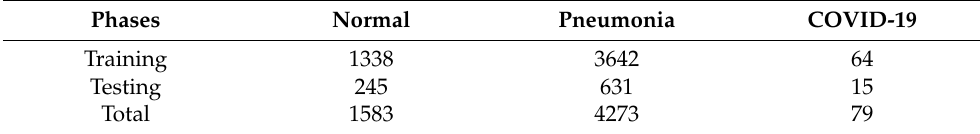
Table 3. Per class X-ray images applied in training and testing